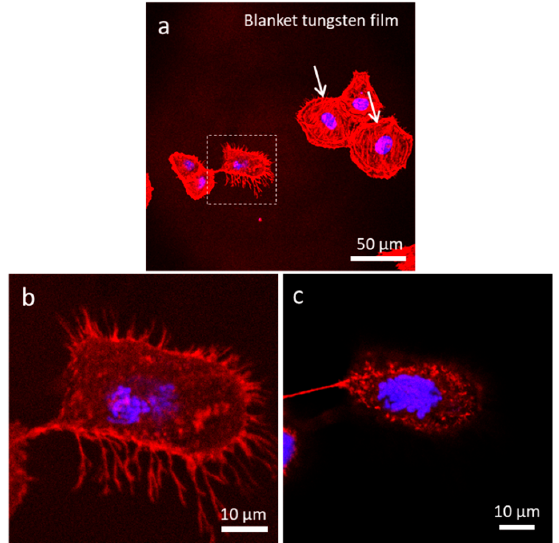
Figure 6. ( a ) Low magnification of a dividing cell possibly in the metaphase on blanket tungsten film. Images ( b , c ) show actin filaments protruding from the bottom half of the cell, while condensed DNA concentrated near the top of the cell ( c ).